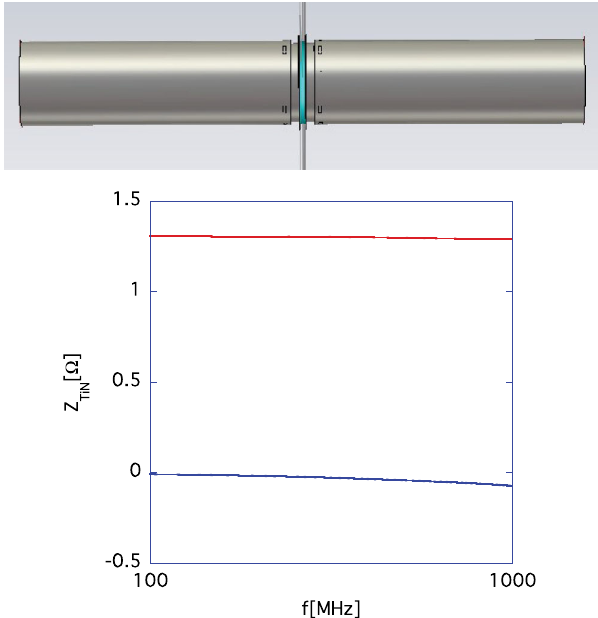
FIG. 8. Simulations (lower) of the longitudinal impedance without tapers in the setup shown in the upper figure. The horizontal axis is frequency in logarithmic